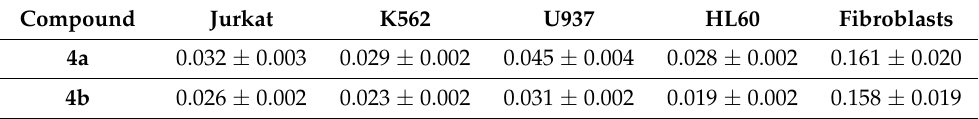
Table 1. Cytotoxic activities IC 50 in vitro of tricyclo[4.2.2.0 2,5 ]dec-7-enes 4a,b measured on tumor cell cultures (Jurkat, K562, U937 and HL60) and normal fibroblasts ( µ M).